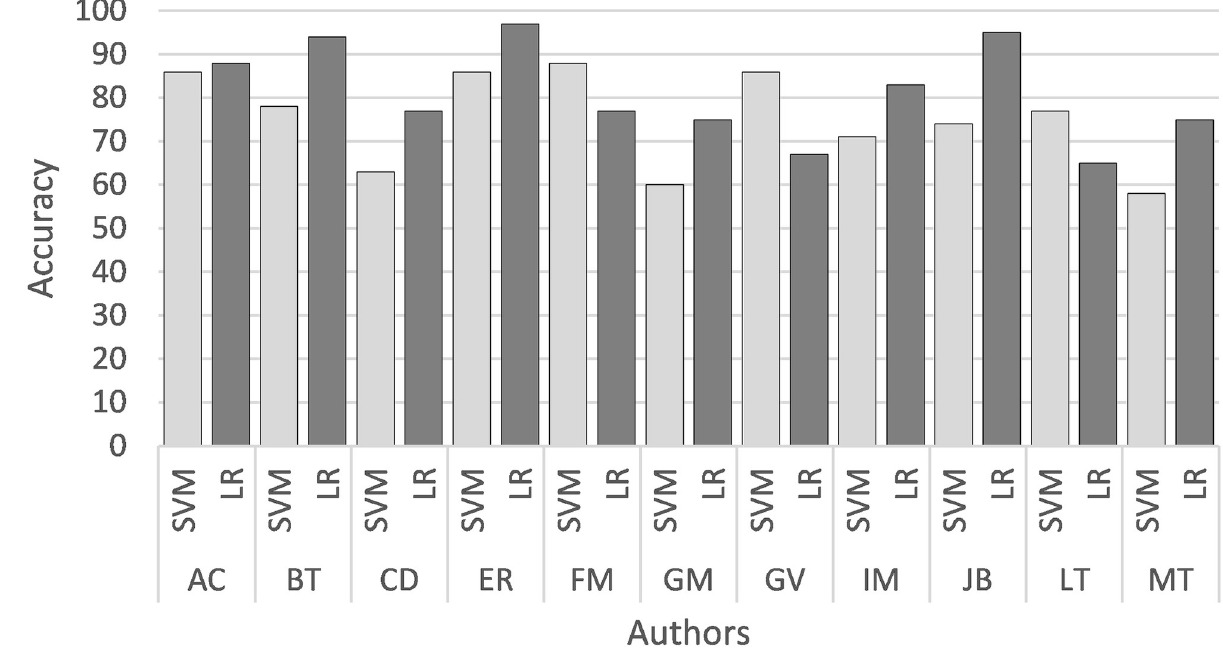
Fig 1. Average accuracy (%) of SVM vs LR.